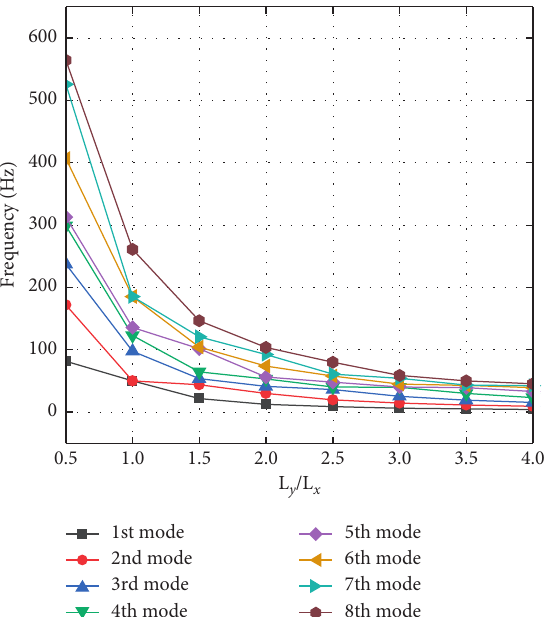
Figure 4: Variation of the first eight-order coupling frequency with various length-width